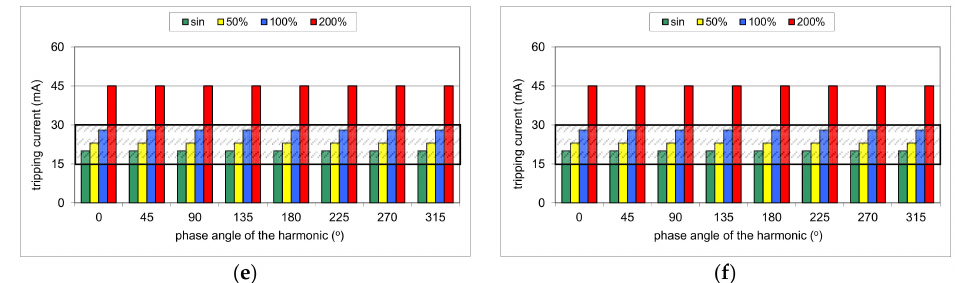
Figure 10. Tripping current of the A-type 30 mA RCD (no. RCD30_3) for testing waveform comprising the fundamental and the following high-frequency components: ( a ) 3 rd harmonic; ( b ) 5 th harmonic; ( c ) 7 th harmonic; ( d ) 11 th harmonic; ( e ) 23 rd harmonic; ( f ) 49 th harmonic. Tested percentages of harmonic-to-fundamental: 50%, 100%, and 200%, and phase angles of the harmonic: 0 ◦ , 45 ◦ , 90 ◦ , 135 ◦ , 180 ◦ , 225 ◦ , 270 ◦ , 315 ◦ .